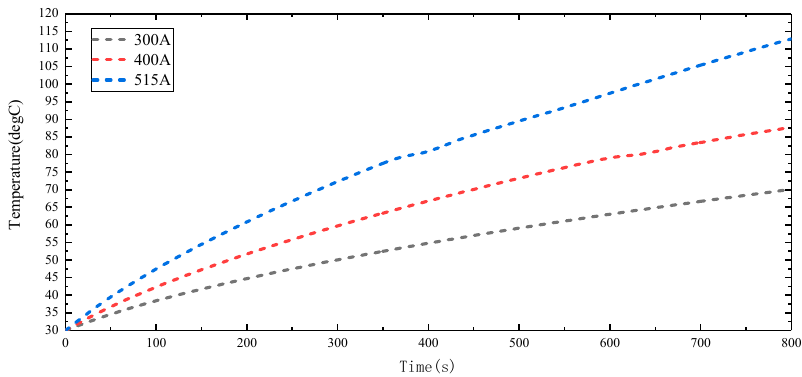
Figure 5. The temperature changes of the center of the thyristor under three maximum forward average current.